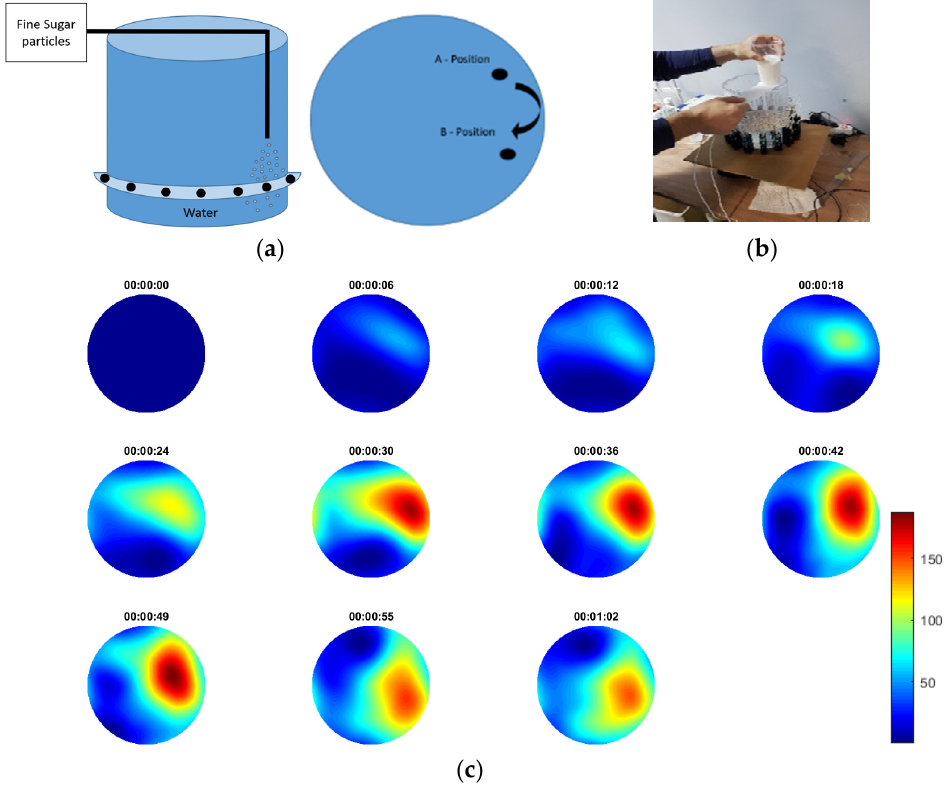
Figure 4. ( a ) Schematic of the experiment with panoramic view of the injection points of the experi- ment. The transition from A to B occurred 29–44 s from the starting time. ( b ) Photo of the experiment. ( c ) Reconstruction with the specific capture time. Scale bar describes pulses’ travel-time de- lays.